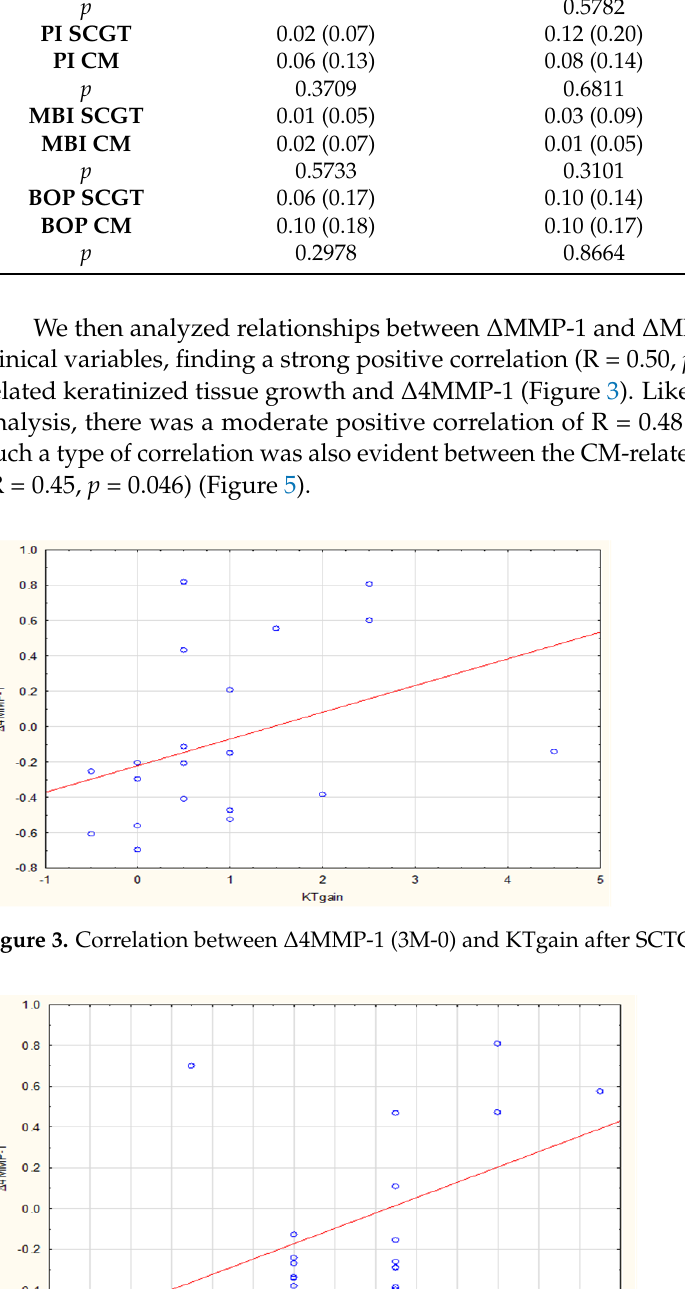
Figure 5. Correlation between ∆ 2MMP-8 (2W- 0) and GTgain after CM. 4. Discussion Contemporary periodontology offers treatment of gingival recessions through mod- ified coronally advanced tunnel technique involving use of either subepithelial connective tissue graft or collagen matrix. This study focused on selected factors in wound healing as reflected in measurable biochemical and clinical parameters involved in the process ob- served after use of both procedures. The well-documented mechanisms of a local response to periodontal surgical proce- dures are also directly relevant to our study. Wound healing involves a substantial num- ber of signaling protein molecules such as chemokines, cytokines, and growth factors as well as proteins of cellular origin—matrix metalloproteinases or adhesion molecules—of which the former play a key role in remodeling of connective tissue and are indicative of ongoing periodontal healing [18]. In our study, it was those mechanisms that may have accounted for an elevated level of MMP-8 in gingival crevicular fluid observed a week after the surgery. Others, too, found the enzyme’s levels raised 4 and 7 days after coronally advanced flap procedure combined with connective tissue graft [19], and 10 days post-op [20]. Both contributed that fact to an increased number of neutrophils (PMNs) and their collagenolytic activity. Our figures reflecting the level of MMP-8 at day-7 examination were comparable with the former author [19] 29.865 ± 29.298 ng/mL against 29.94 ± 4.11 ng/mL, respectively. A notable fact was that our MMP-8 figures after SCTG procedure were also close to those measured after CM (29.865 ± 29.298 ng/mL and 29.437 ± 21.936 ng/mL, respectively), although we could not find corresponding findings in the literature. In both this and Jha et al. studies, the notable drops in MMP-8 concentration in suc- cessive examinations may indicate that it is a crucial enzyme involved at the early stage of healing after root coverage surgery using either SCTG or CM. At the final examination in our study, 3 months post-op, we found that the mean MMP-8 concentration was lower than in week-2 examination with regard to each surgical procedure. Even so, it was higher than at baseline. This fact in turn may point to the enzyme’s role in periodontal remodel- ing, which at month-3 was potentially still in progress. In Jha et al. MMP-8 concentration returned to its baseline level 6 months post-op [19]. Although a 3-month observation